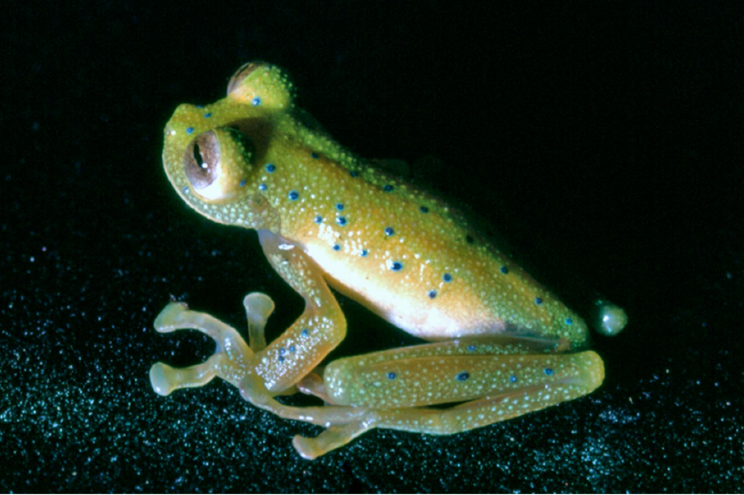
Figure 174. Nymphargus megacheirus in life. Adult male, holotype, KU 143245. Photo by W. E. Duellman. Diagnosis: (1) Vomers lacking teeth; (2) snout truncated in dorsal and lateral profiles (Figure 175); (3) tympanum relatively small, its diameter 18.8%–25.4% eye diameter, dorsal border of tympanic annulus covered by supratympanic fold, tympanic membrane pigmented as surrounding skin; (4) dorsal skin of males shagreen to pustular, shagreen in females; numerous spicules present in males; in females, spicules present only on head, tympanic region, and limbs; (5) skin of venter areolate; pair of enlarged subcloacal warts; (6) anterior two-thirds to three-fourths of venter covered by white parietal peritoneum, posterior portion transparent (condition P3); white pericardium; translucent peritoneum covering intestines, stomach, testes, kidneys, gall bladder, and urinary bladder (condition V1); (7) liver tetralobed, two large ventral lobes partially covering two smaller lobes; hepatic peritoneum transparent (condition H0); (8) humeral spines absent; (9) hand webbing absent between inner finger, absent or basal between / 2 / 2 outer fingers (Figure 175), webbing formula: III (2 1 –3)—(2 1 –3) IV; (10) foot about one-half webbed: